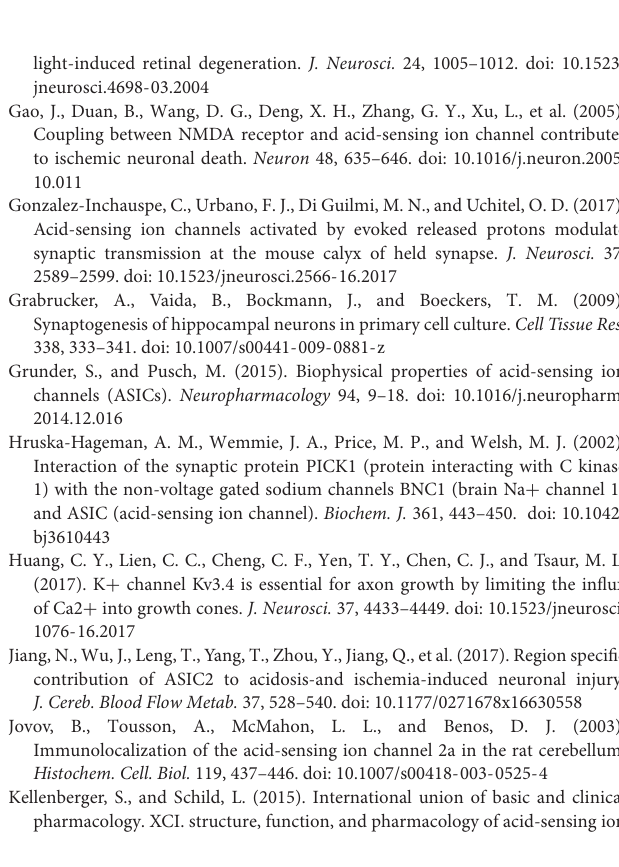
FIGURE S1 | This is a full scan of the entire original gel for Figure 2A . FIGURE S2 | This is a full scan of the entire original gel for Figure 2B . FIGURE S3 | Identification of specificity of ASIC1a and ASIC2a antibodies. (A) Detection of ASIC1a protein in cultured hippocampal neurons by double-staining immunofluorescence. Nuclei were immunostained with DAPI (blue). ASIC1a was labeled with FITC (green). (B) Detection of ASIC2a protein in cultured hippocampal neurons by double-staining immunofluorescence. Nuclei were immunostained with DAPI (blue). ASIC2a was labeled with FITC (green). ASIC1a and ASIC2a protein do not be detected after pretreatment with the corresponding antigen (Ag) peptide. Scale bars, 20 µ